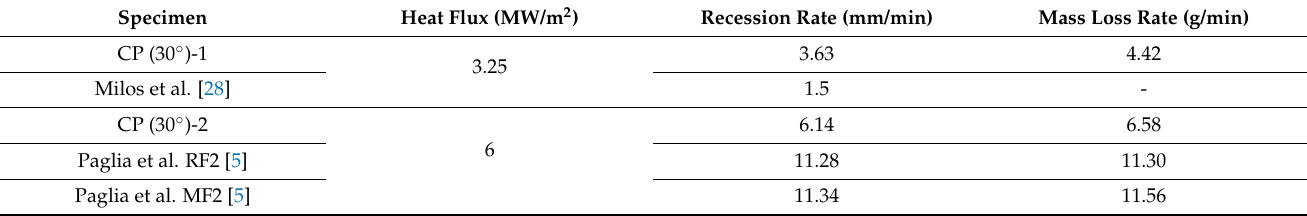
Table 3. Comparison of mass loss rates and recession